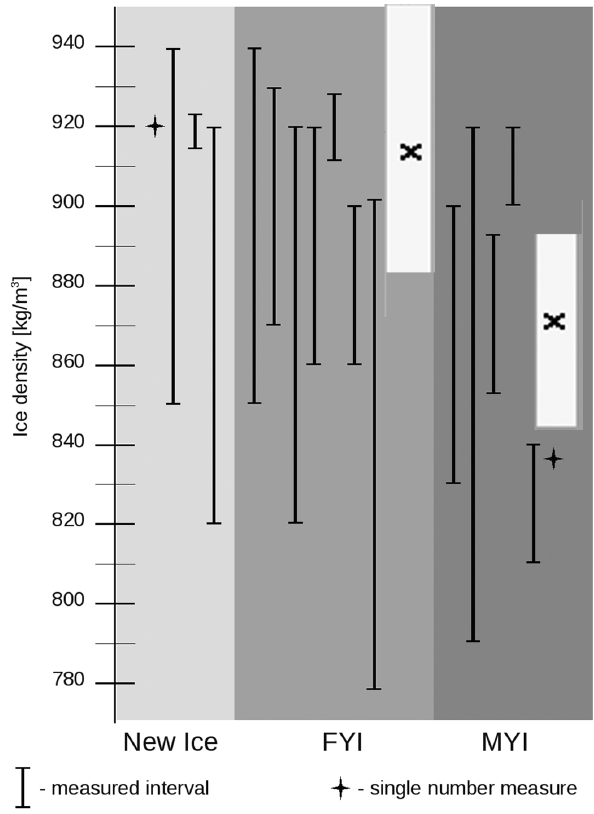
Fig. 2. A composite of sea ice density data measurement ranges obtained from Timco and Frederking (1995) and references there, as well as from papers by Malmgren (1927), Mobley et al. (1998), Kubishkin and Skutina (2004) and Schulson et al. (2006). The mea- surements were conducted using mostly mass/volume technique. The white column under FY ice represents the mean and standard deviation of density retrieved from the Sever data. The white col- umn under MY ice represents the best estimate of mean and stan- dard deviation of density from published